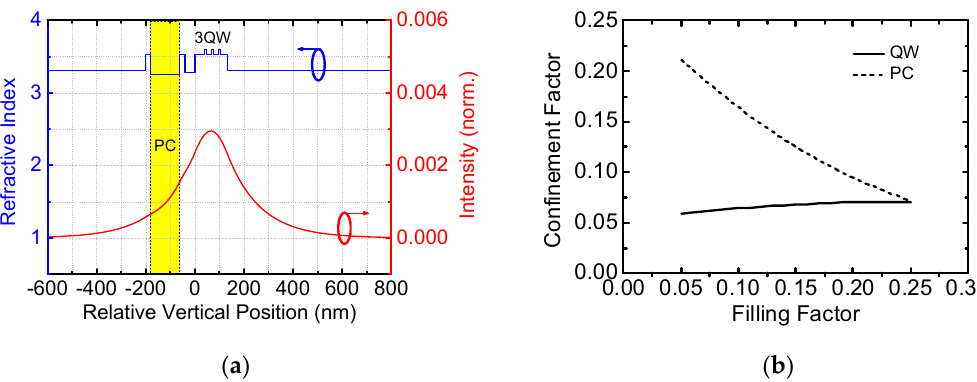
Figure 2. Air-hole PC-SEL: ( a ) the normalized intensity as well as refractive index profile at filling factor f = 0.16 ( b ) the 1D intensity overlap within QW and PC regions as a function of PC filling factor.